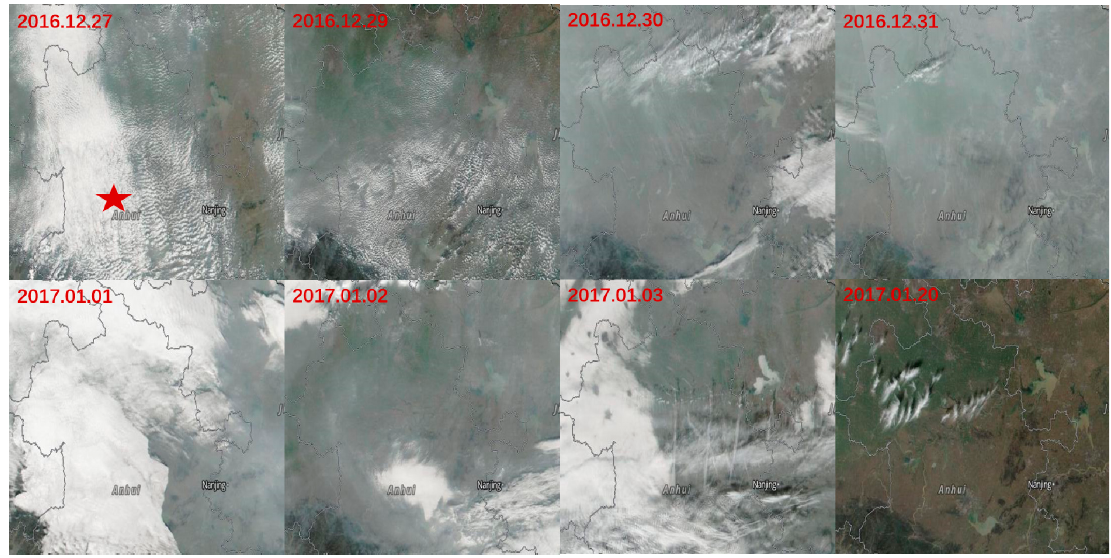
Figure 3. The Visible Infrared Imaging Radiometer Suite (VIIRS) Suomi National Polar-orbiting Partnership (NPP) 1 km true-color images during the foggy-hazy composite pollutions and a sunny day.